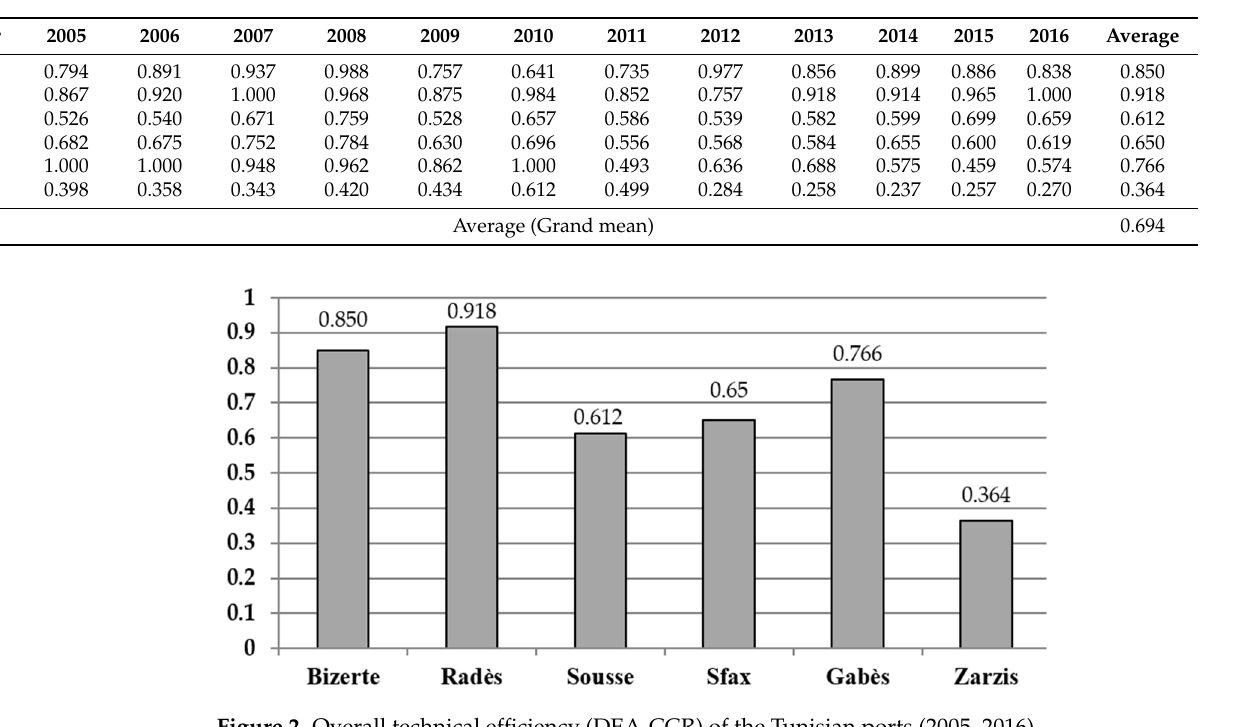
Table 4. Overall technical efficiency scores (DEA-CCR) of Tunisian ports.